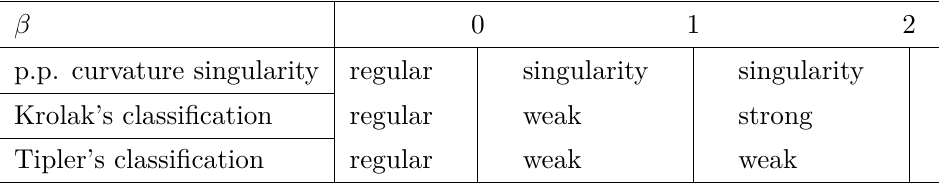
Table 1 . Classification of